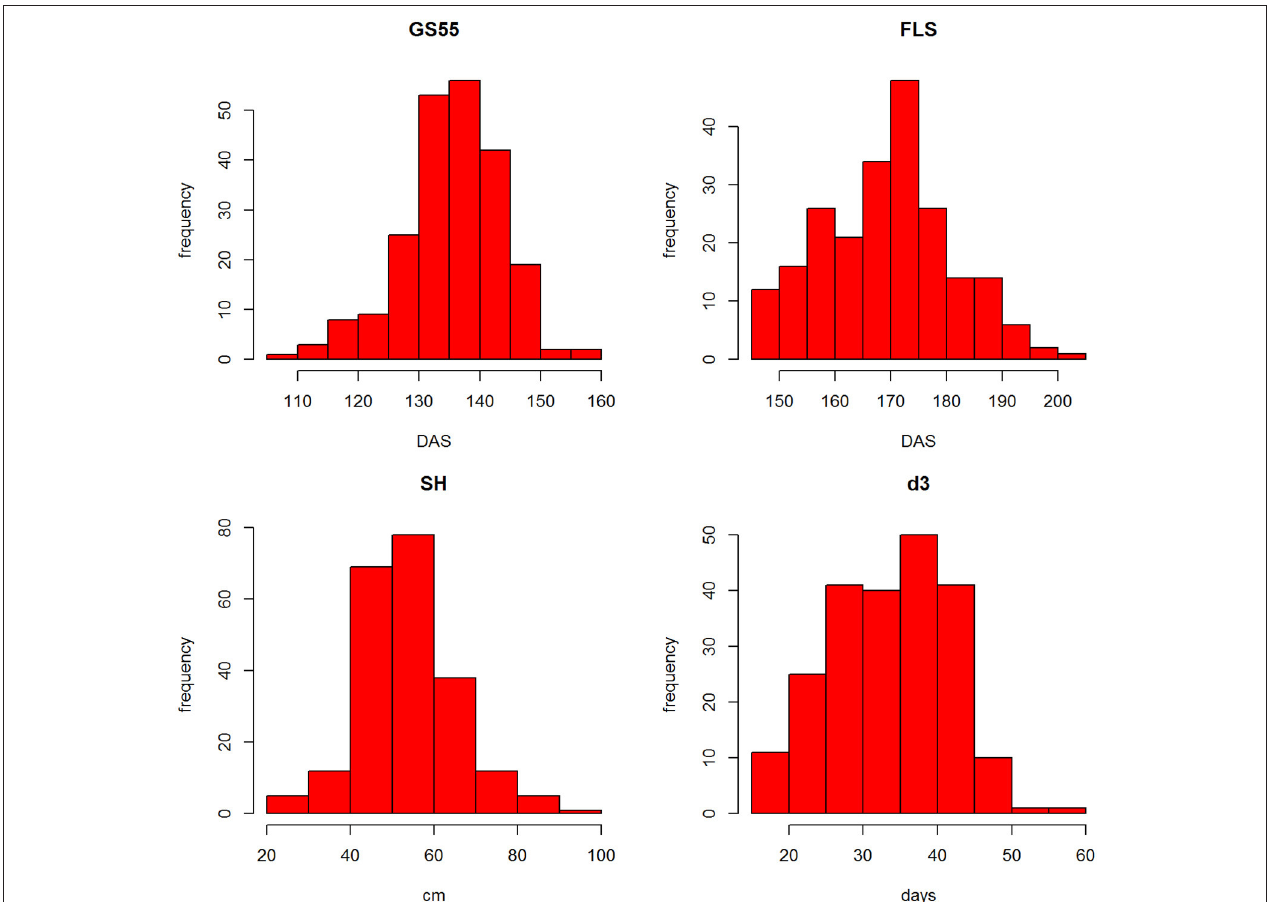
FIGURE 3 | Frequency distributions of GS55, FLS, SH, and d3 from all RILs.